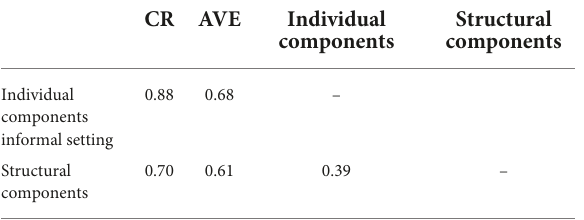
TABLE 5 Measuring barriers to informal learning.